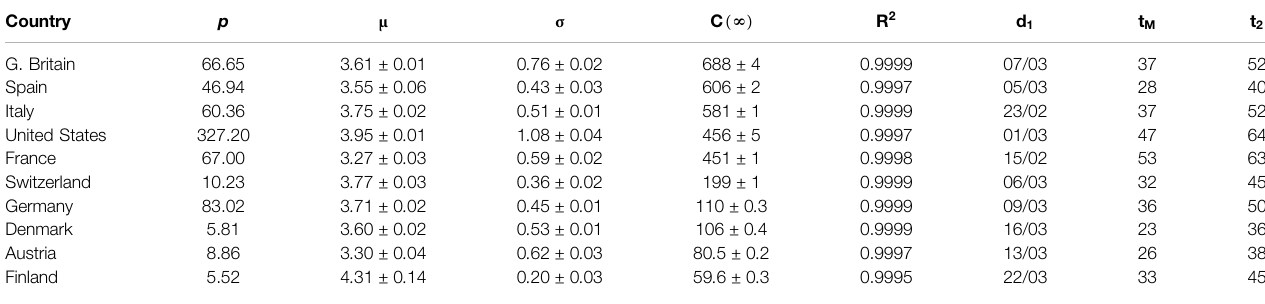
TABLE 1 | Parameters for SHR model (con fi rmed deaths, fi rst wave). p : country ’ s population (millions). μ and σ : parameters in the lognormal distribution. C ( ∞ ) : asymptotic valueforaccumulatedcases(permillionperson). R 2 and r 2 :R-squaredcorrelationfactorsfor C ( t ) and c ( t ) ,respectively. t M and t 2 :maximumandsecondin fl ectionpoint (origin is the fi rst of January 2020).